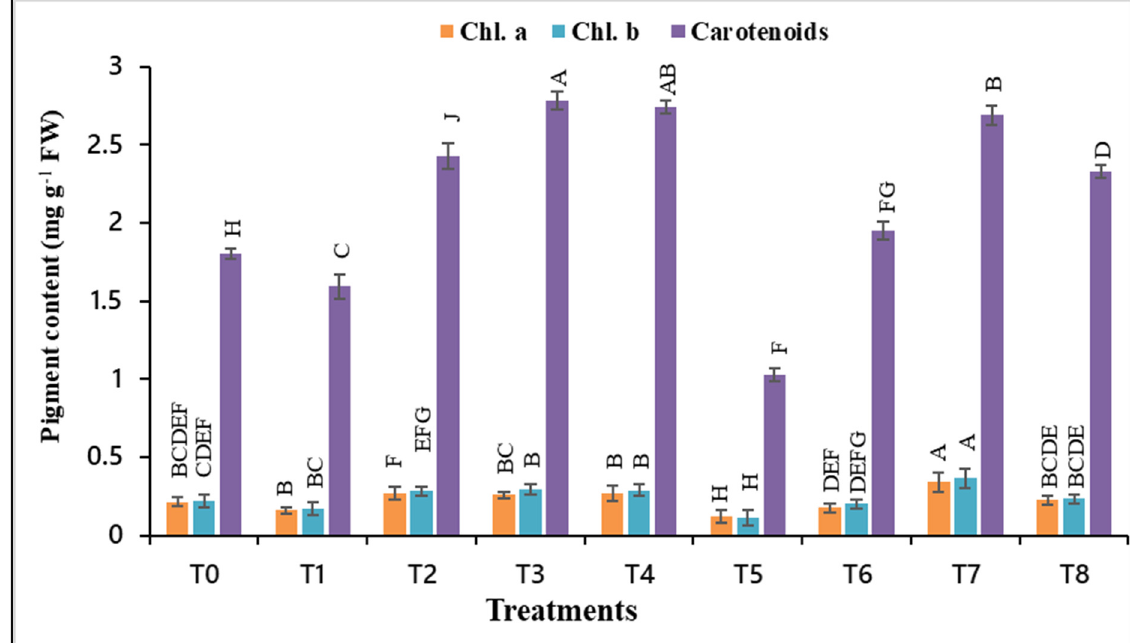
Figure 1. Effect of AsA and/or α -toc on chlorophyll (Chl. a, b) or carotenoid contents in fresh leaves of A. sativa under drought stress. Different alphabetical letters indicate significant differences among treatments at p < 0.05, according to the LSD test. (T0) control: normal watering + 0 mg AsA and α -toc, (T1): 15 days drought + 0 mg AsA and α -toc, (T2): 15 days drought + 200 mg AsA, (T3): 15 days drought + 200 mg α -toc, (T4): 15 days drought + 200 mg AsA and α -toc, (T5): 25 days drought + 0 mg AsA and α -toc, (T6): 25 days drought + 200 mg AsA, (T7): 25 days drought + 200 mg α -toc, (T8): 25 days drought + 200 mg AsA and α -toc.